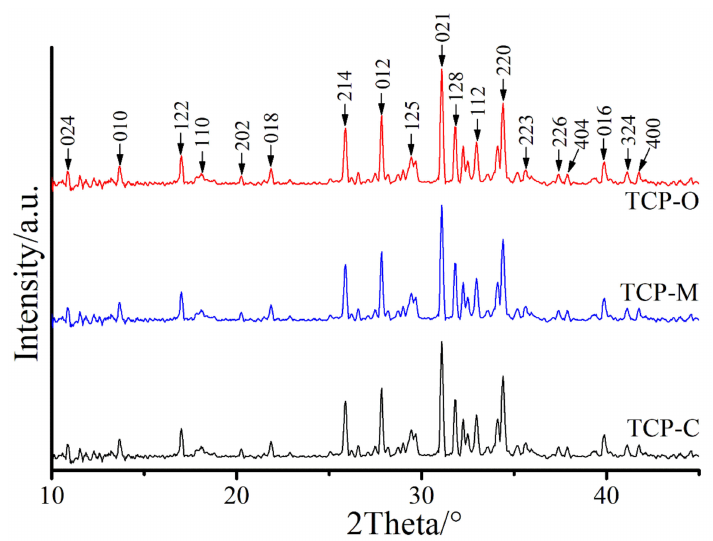
Figure 11. The XRD patterns of TCP-C, TCP-M, and TCP-O samples.